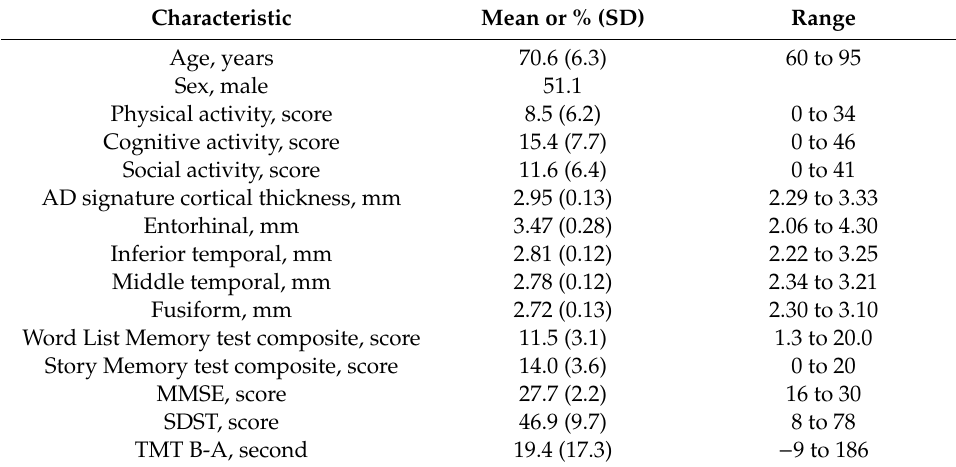
Table 1. Baseline characteristics of study